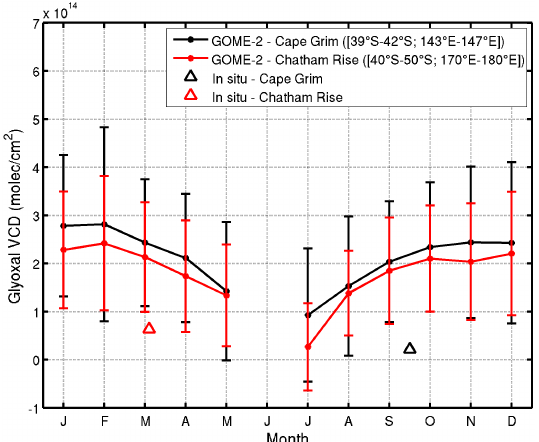
Figure 5. Seasonal glyoxal VCDs retrieved from GOME-2 and cal- culated from surface-based observations at Cape Grim and Chatham Rise. GOME-2 values are for all data averaged between 2007 and 2012, for regions encompassing Cape Grim and Chatham Rise. Er- ror bars for surface-based VCDs are insignificant on this scale and are not shown (see text for